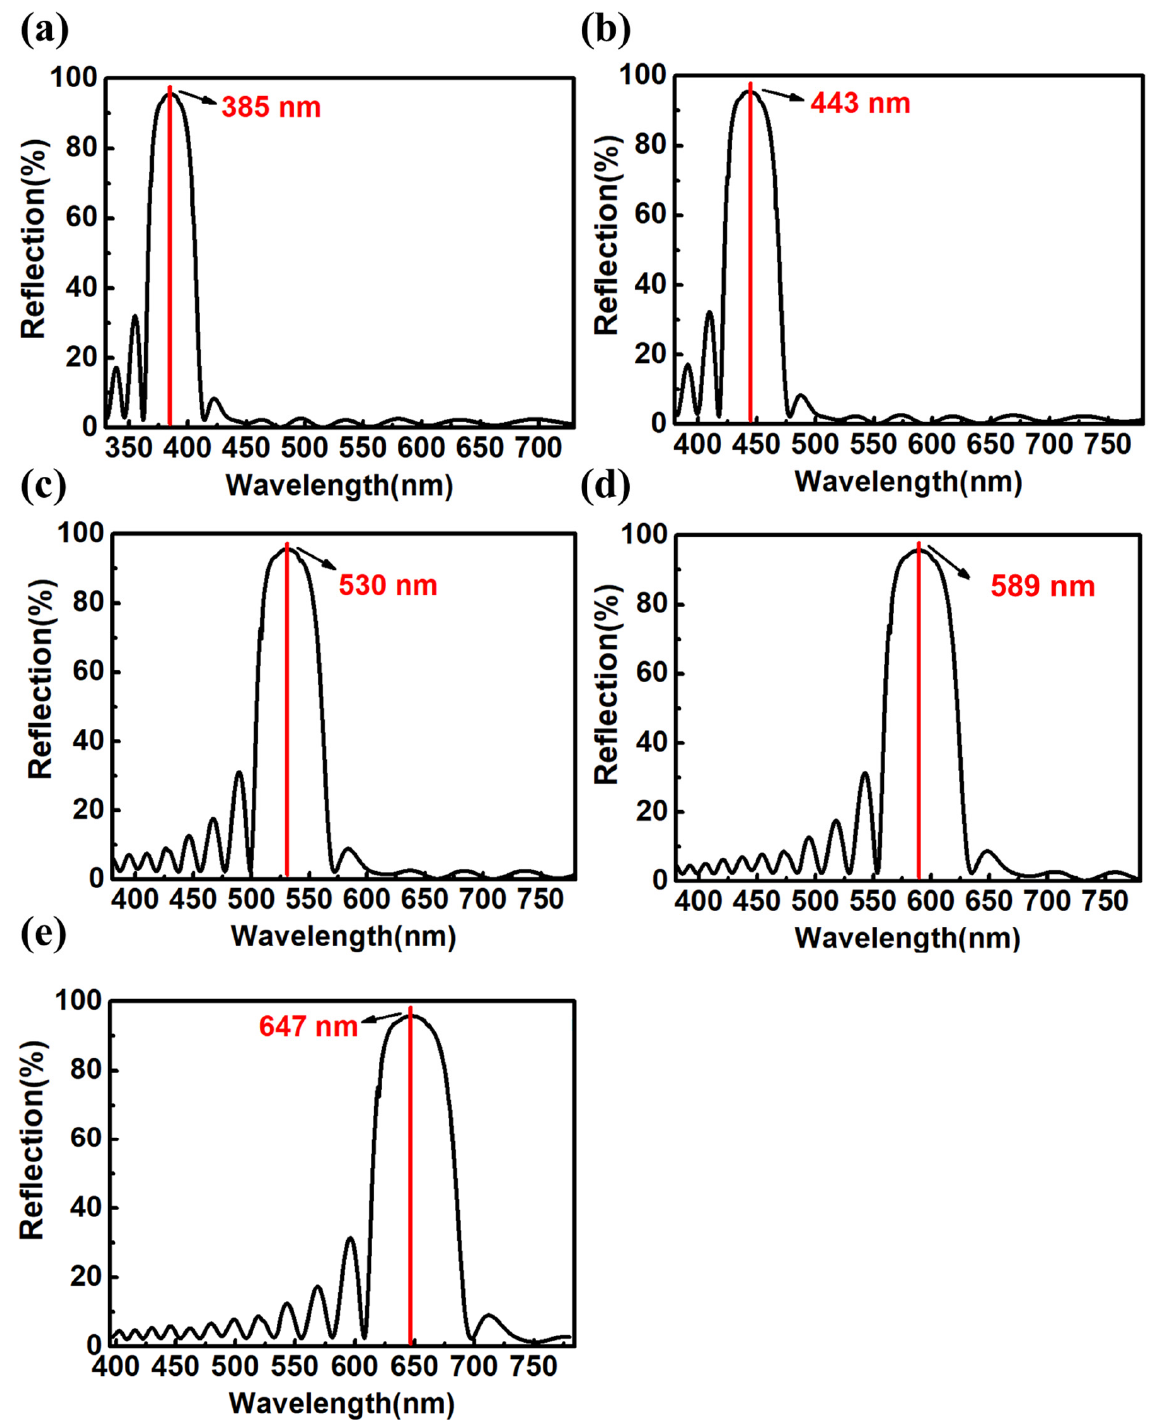
Figure 6. Simulation results of reflection spectra of IO structure containing PEGDA matrix and voids with diameters of ( a ) 130 nm; ( b ) 150 nm; ( c ) 180 nm; ( d ) 200 nm; and ( e ) 220